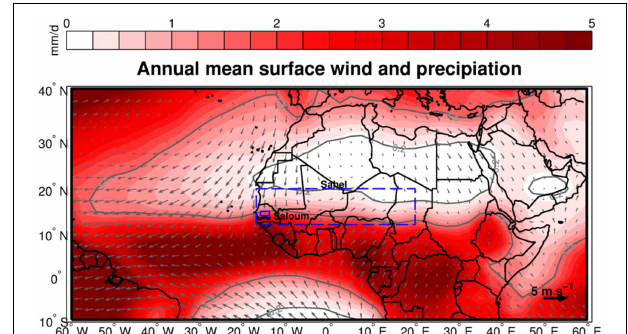
FIGURE 1 | Annual mean of precipitation (shaded, mm/d) and surface wind (vector, m/s). The blue rectangle shows the Sahel region defined in the text and the small blue rectangle indicates the location of Saloum River Delta. The 0.2 and 1.5mm/d isohyets are highlighted in gray